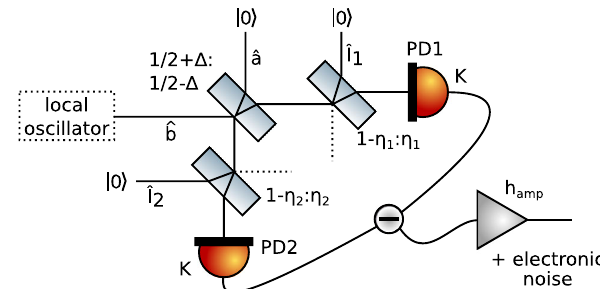
þ Δ . The photo 2